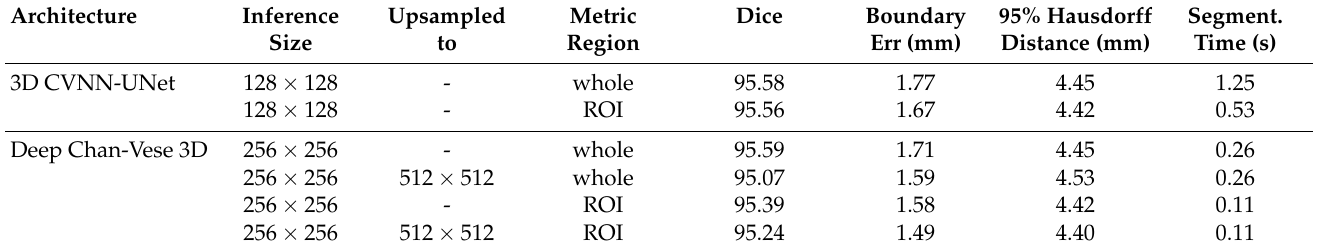
Table 1. 3D CVNN-UNet and Deep Chan-Vese 3D evaluation. Deep Chan-Vese 3D is estimated both at the inference resolution and full resolution. Metrics are calculated in two regions; “whole”: on all the slices that are annotated and with the whole axial plane, “ROI”: based on the cropping regions used by DEEDS [42] + JLF [43] and DenseVNet [36]. The 3D CVNN-UNet was fed in ϕ 0 with an average Dice score of 87.58.